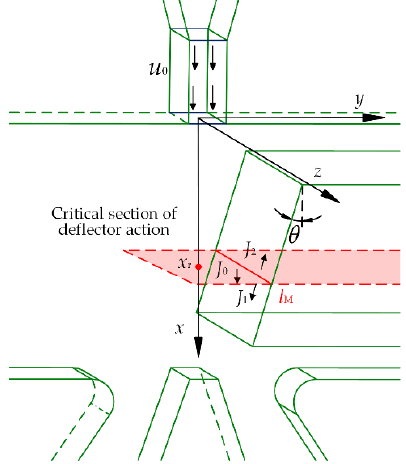
Figure 5. Jet impact on the